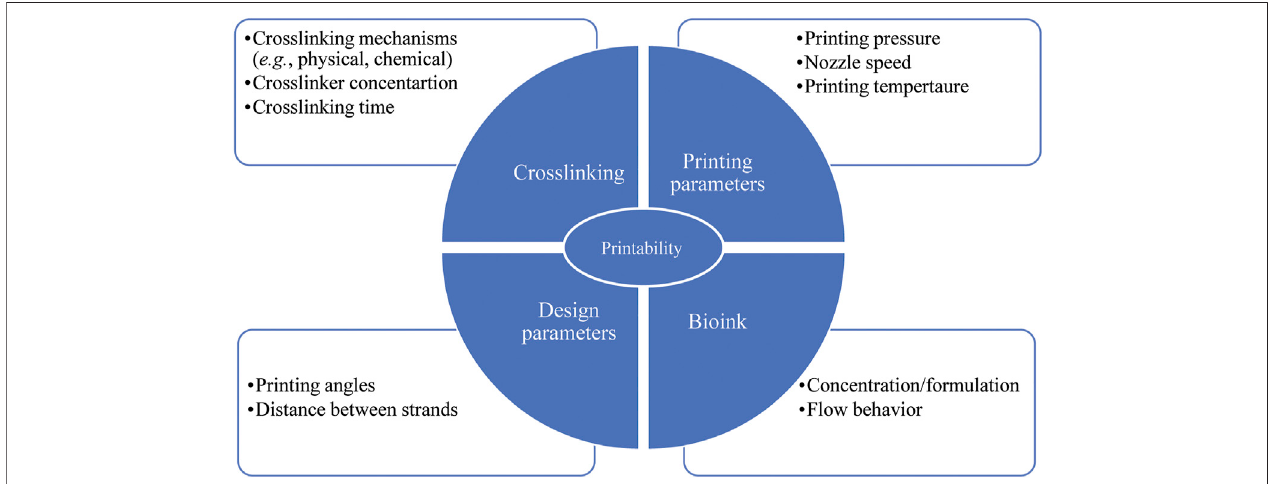
FIGURE 4 | Parameters affecting scaffold printability; factors related to crosslinking, bioink and printing parameters have to be taken into consideration to achieve both favorable printability and cell viability.